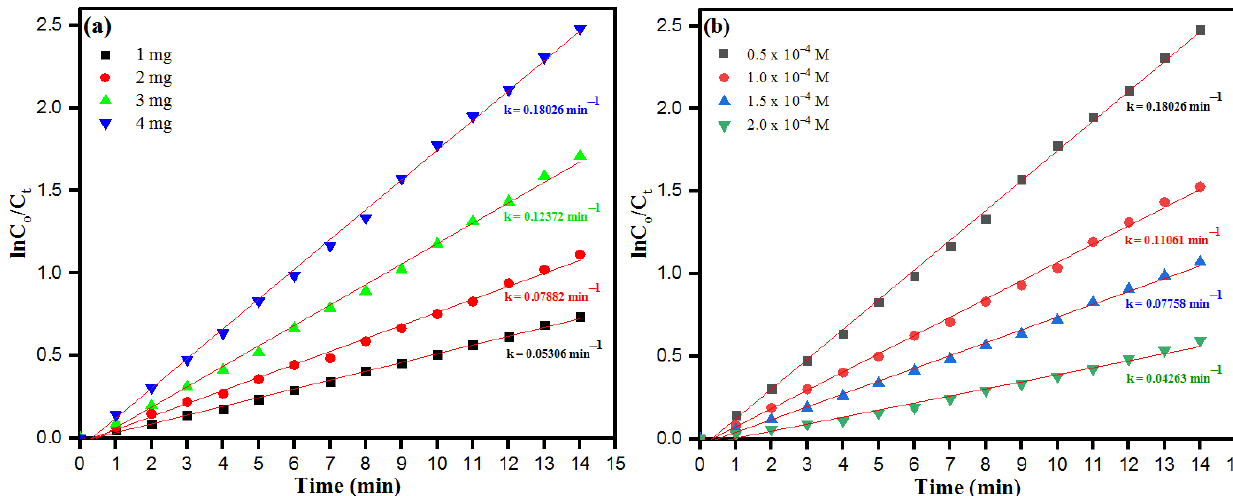
Figure 10. Plot of lnC o /C t vs time for the reduction of CR as of function of ( a ) catalyst dosage and ( b ) initial CR dye concentration.